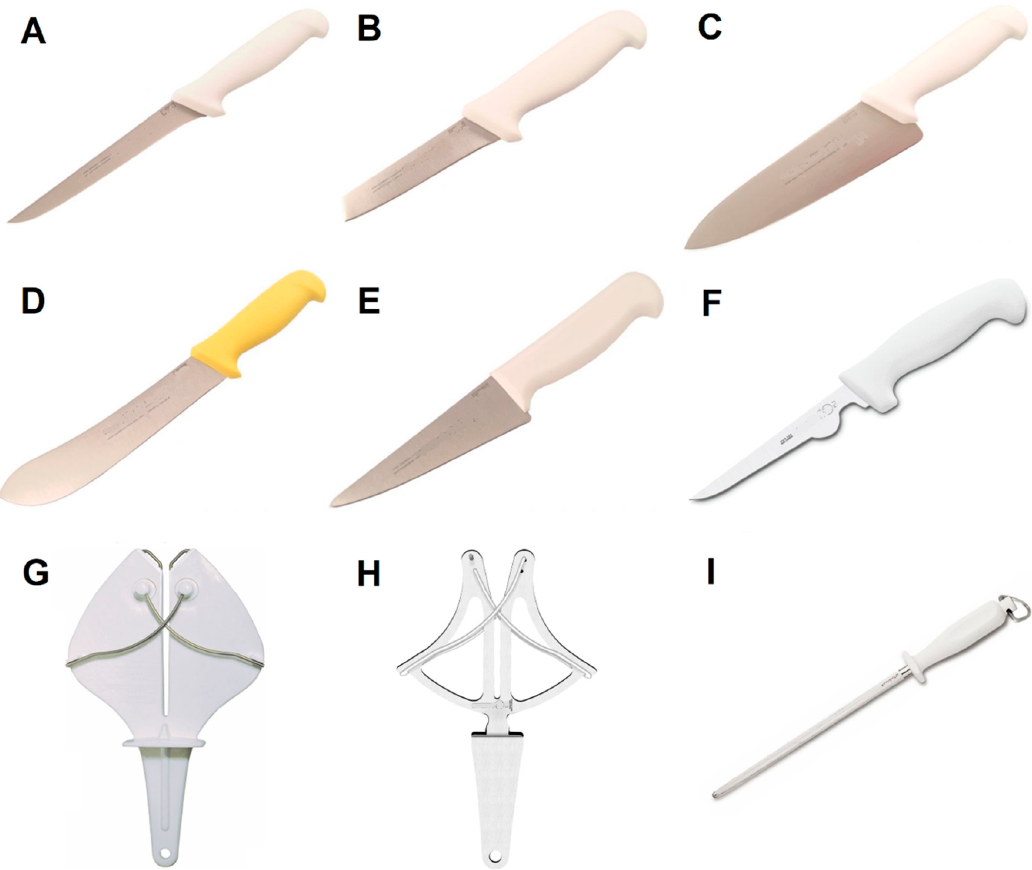
Figure 1. Knives used by workers: ( A ) slaughterhouse 1, cleaning breast and deboning leg;